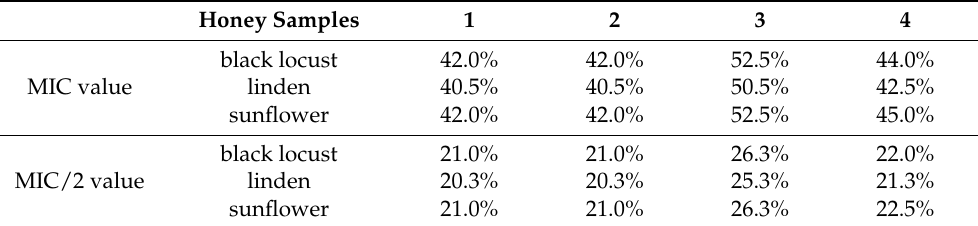
Table 6. The MIC and MIC/2 value of linden, black locust, and sunflower honey. Honey Samples